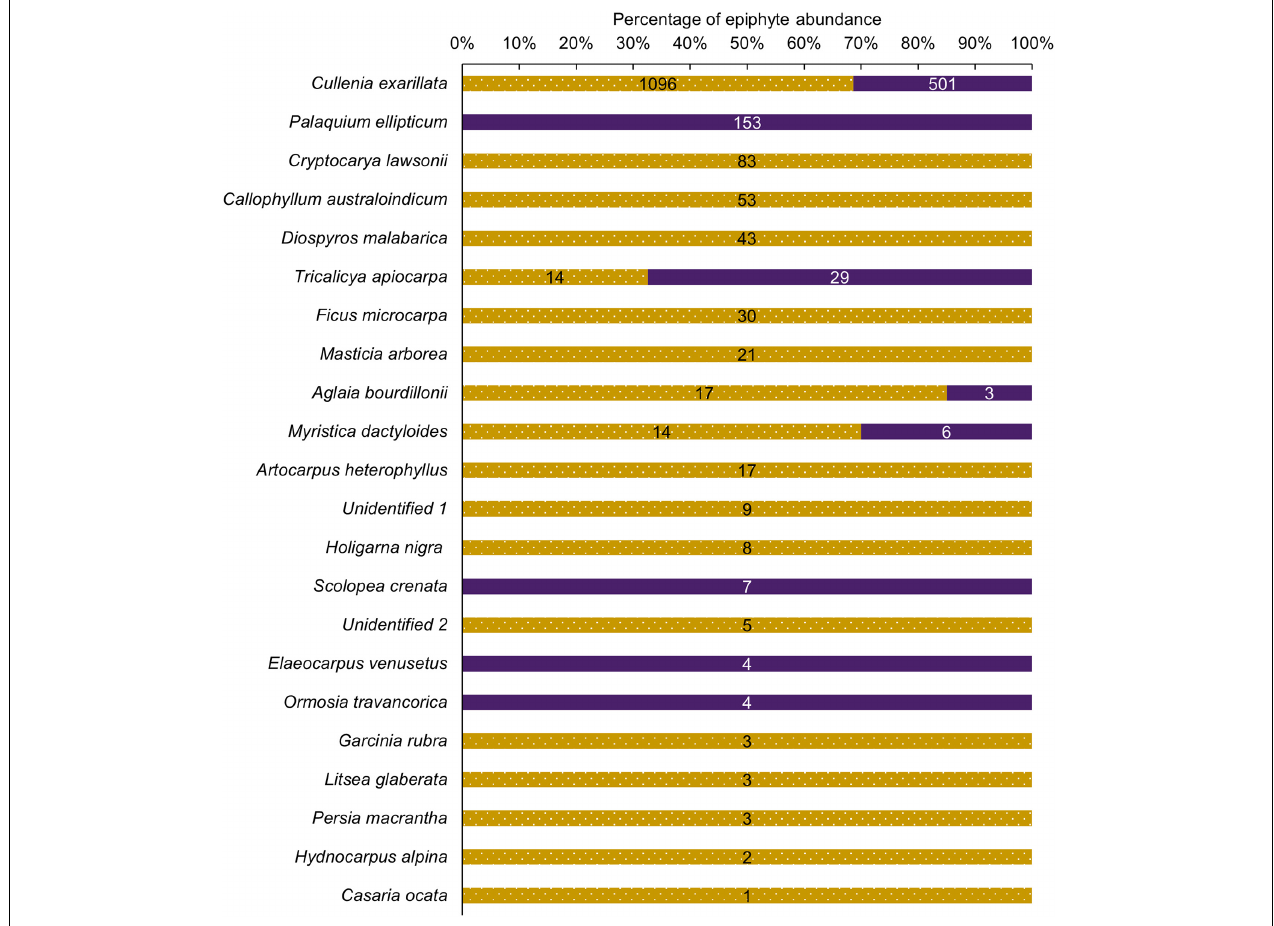
FIGURE 4 | Relative abundance of vascular epiphytes encountered on host tree species in the unlogged (purple) and the selectively logged forest (dotted gold) forest is shown as a percentage of the total abundance. Actual relative abundance values are shown on respective